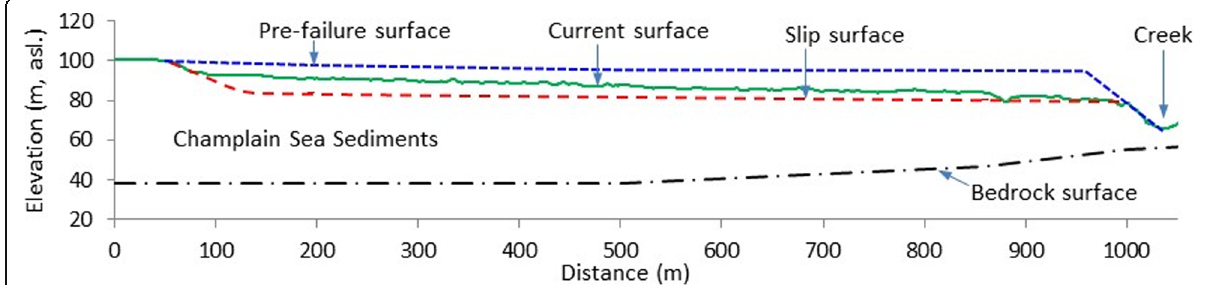
Fig. 3 Cross-section of Breckenridge landslide along the approximate centerline shown in Fig. 2 (vertical exaggeration: